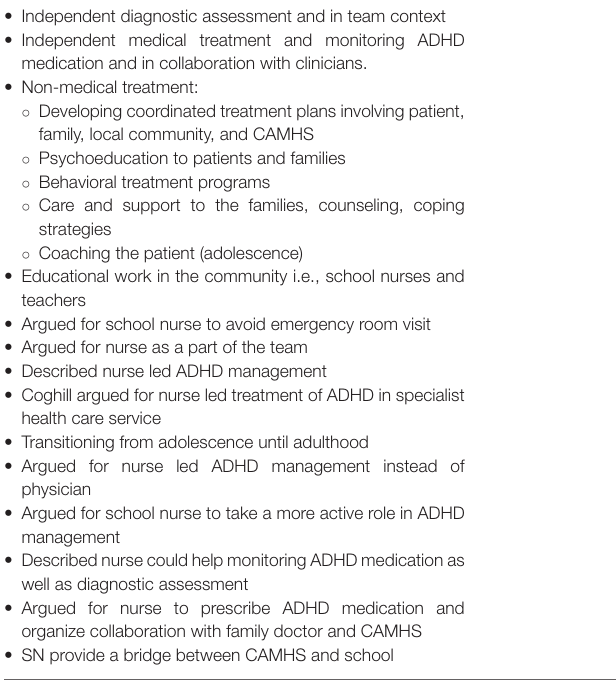
TABLE 1 | Summary of recommendations regarding nurse role in ADHD diagnostic assessment, treatment, and management: a literature review.